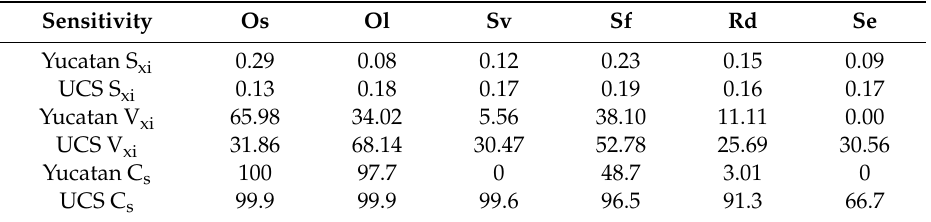
Table 6. Average sensitivity values for the